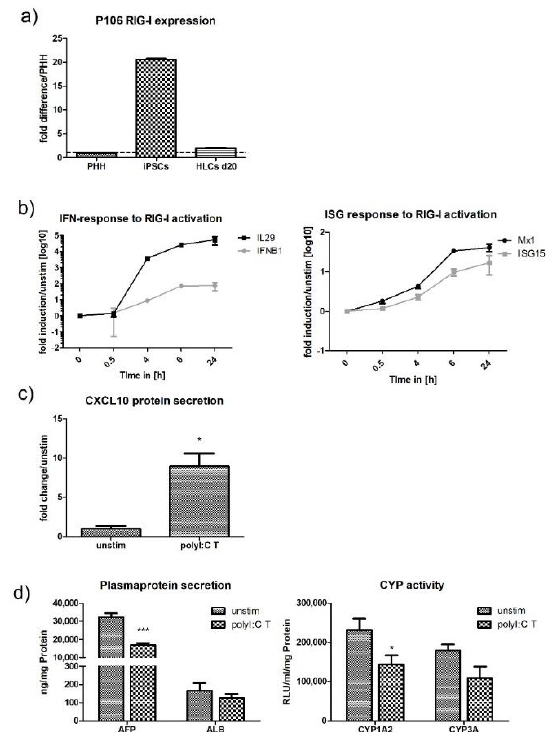
Figure 2. RIG-I expression and activation in P106-HLCs. ( a ) Comparison of baseline RIG-I mRNA expression in PHH, P106-iPSCs, and d20 P106-HLCs. Gene-expression was determined by qPCR, normalised to b2m, and compared to PRR gene-expression in primary human hepatocytes. iPSCs expressed high levels of RIG-I mRNA. Upon differentiation, RIG-I levels became downregulated and on d20 of differentiation were similar to PHH ( N = 3). ( b ) P106-HLCs mount strong innate immune responses upon activation of RIG-I. qPCR data shows that RIG-I activation by polyI:C transfection induced type I and III IFN expression in a time-dependent manner, which then induced ISG-expression (ISG15, Mx1) ( N = 3). ( c ) Expression of CXCL10 protein upon transfection with polyI:C. PolyI:C transfection induced significant expression of CXCL10 protein as determined by enzyme-linked immunosorbent assay (ELISA) 24 h after transfection ( N = 3). ( d ) E ff ect of innate immune activation on hepatocyte metabolic activity. Cells were transfected with polyI:C for 16 h before CYP-activity and plasma protein production was measured and compared to unstimulated cells. The generation of